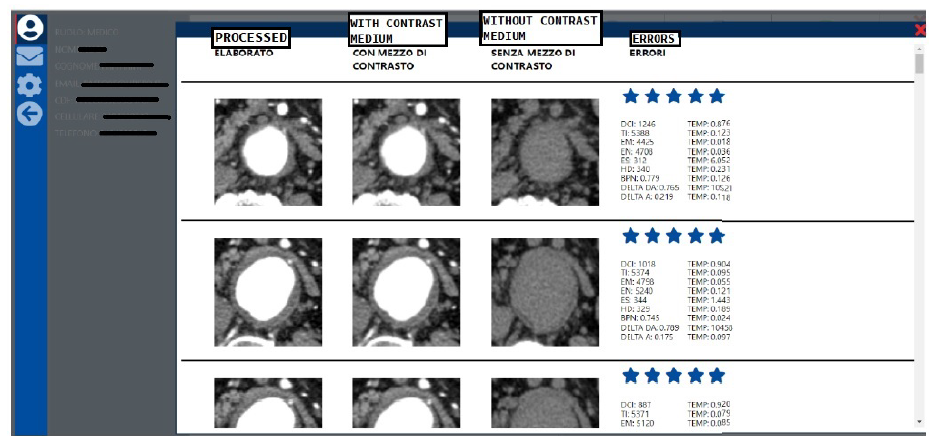
Figure 10. Doctor user interface for the results